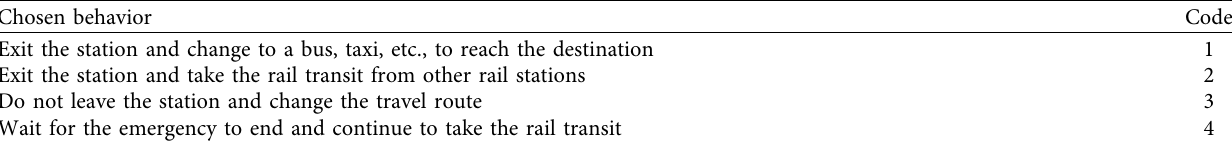
Table 3: Description of dependent variables.